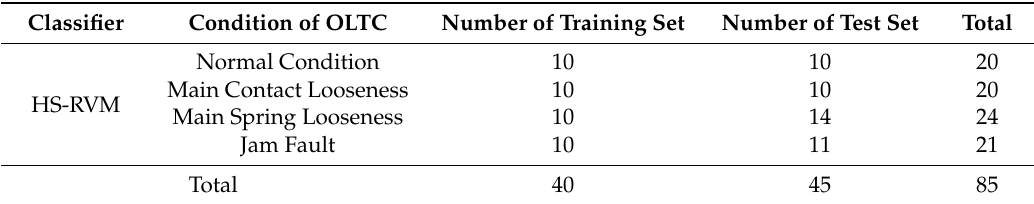
Table 4. The selections of training set and test set.